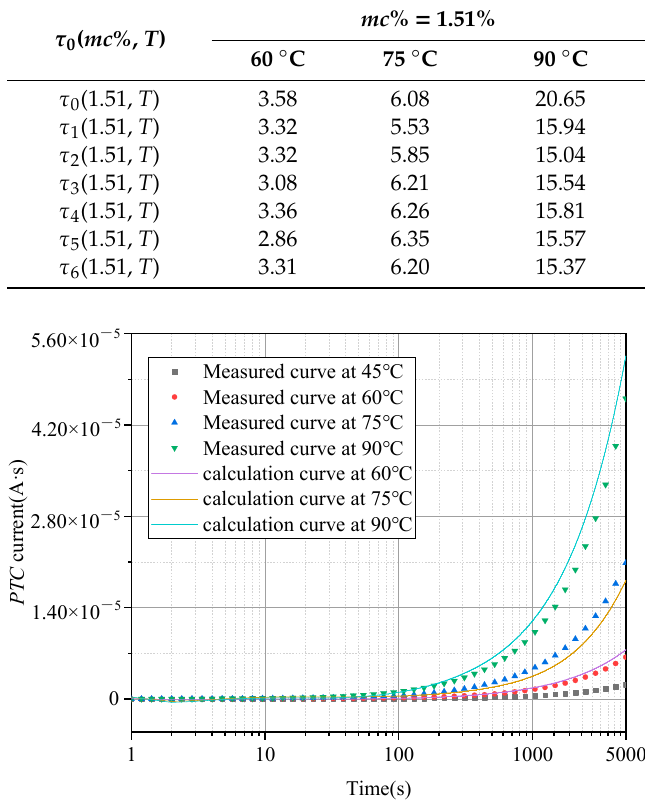
Figure 6. Measured and calculated PTC curves of verification sample.